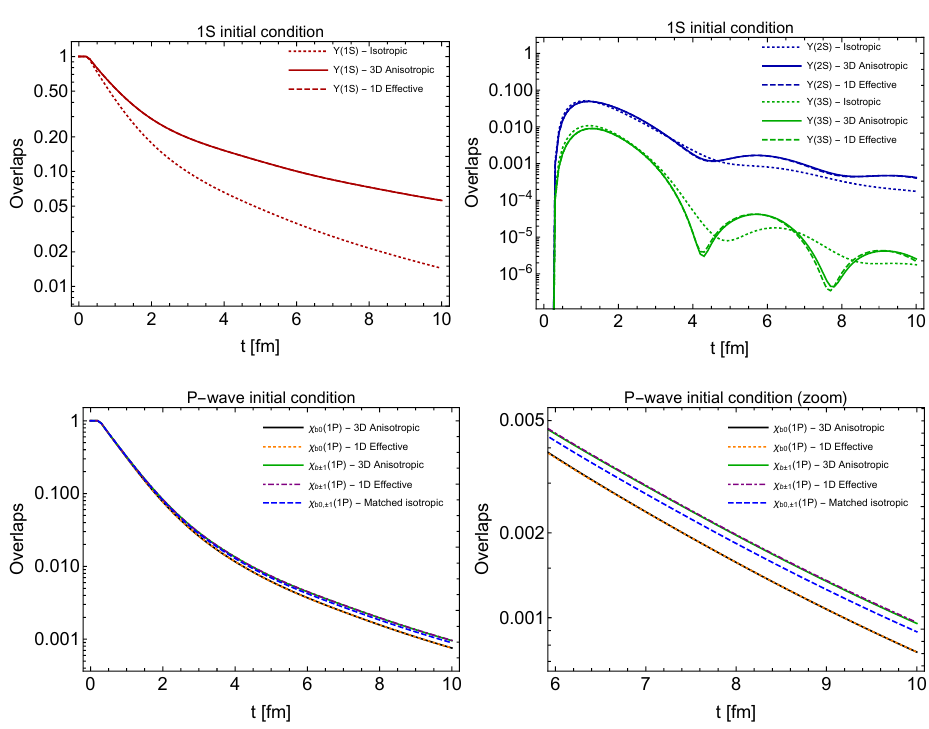
Figure 1. The top row shows the overlaps of Υ (1 S ), Υ (2 S ), and Υ (3 S ) resulting from real-time solution of the Schrödinger equation. Here we initialized the wave function as pure Υ (1 S ) eigenstate. The bottom row shows the time evolution of the bottomonium p-wave overlaps resulting from initialization with di ff erent p-wave polarizations